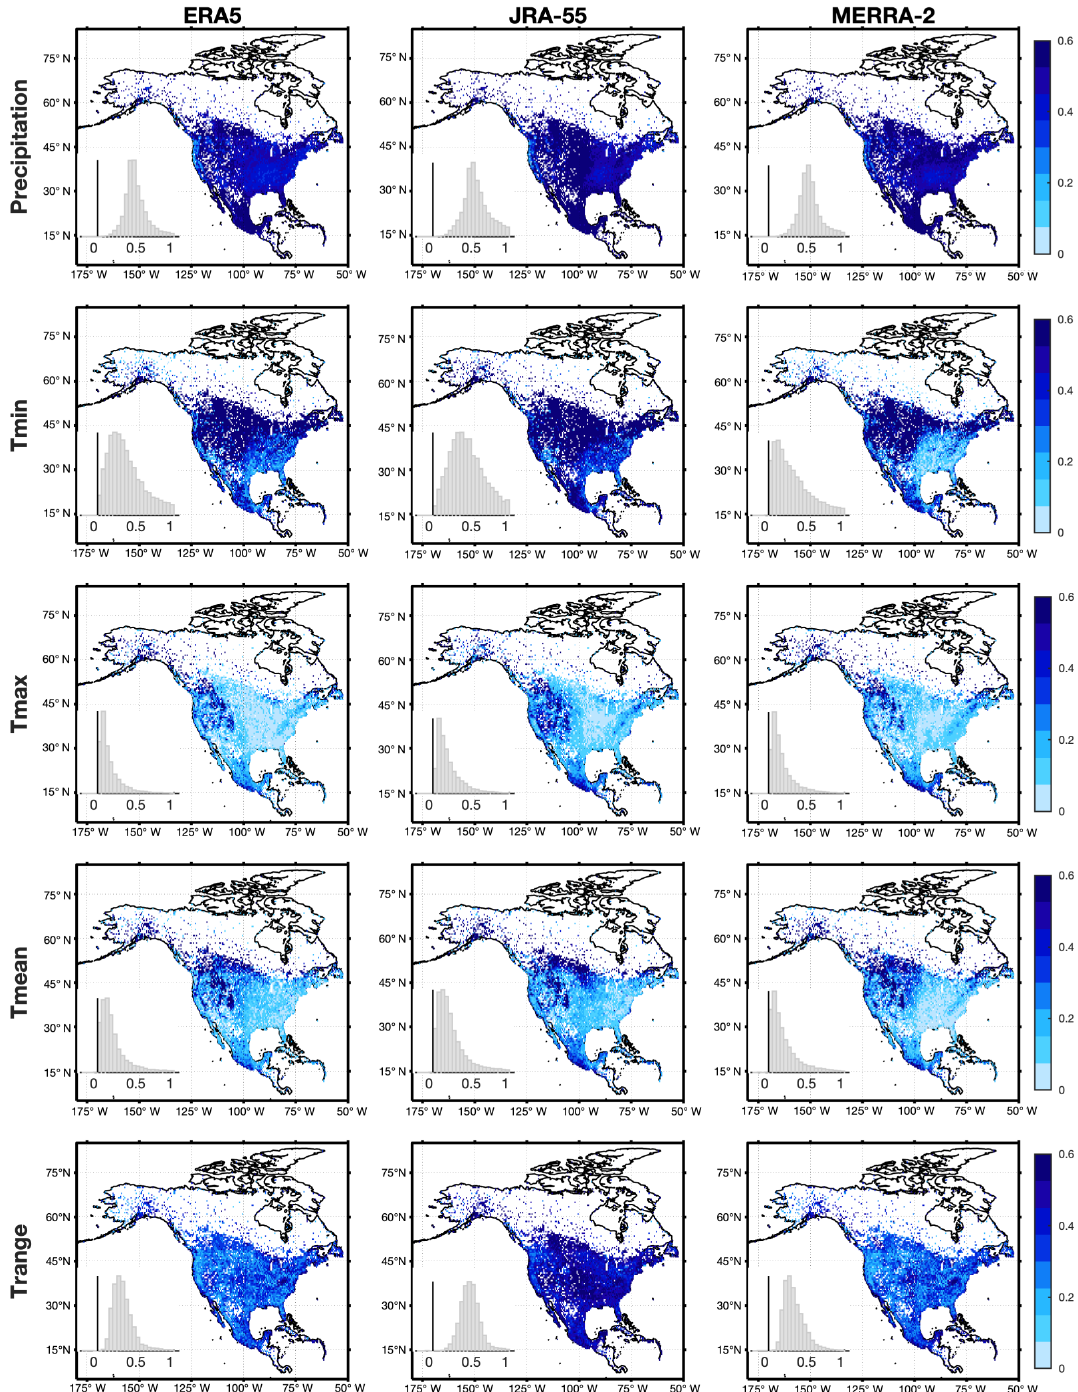
Figure 14. Spatial distributions of KGE (cid:48) differences between SCDNA estimates and three reanalysis products (ERA5, JRA-55, and MERRA- 2). The nested histograms show KGE (cid:48) differences between the SCDNA and reanalysis products. Corrected SCDNA estimates are